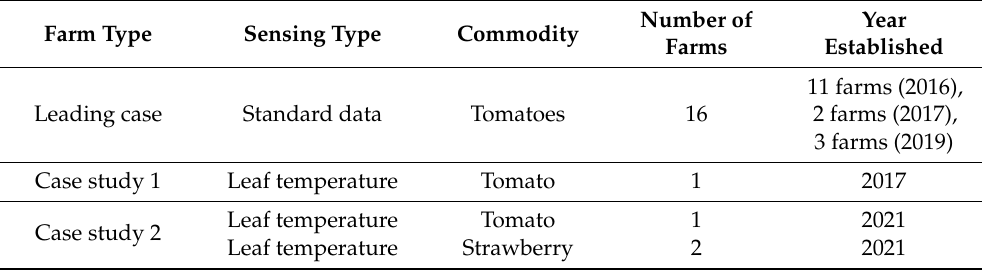
Table 3. An overview of case studies used in this study. For leading cases, data on the following variables were collected: air temperature, humidity, CO 2 , illuminance, wind direction, wind speed, rainfall, and yields. Case study 1 focused on the development of software, hardware, and information collection, while case study 2 was established to improve a framework for data utilization. All farms were equipped with a complex environment controller (mainly for aeration) and nutrient solution suppliers. Number of Year Farm Type Sensing Type Commodity Farms Established 11 farms (2016), Leading case Standard data Tomatoes 16 2 farms (2017), 3 farms (2019) Case study 1 Leaf temperature Tomato 1 2017 Leaf temperature Tomato 1 2021 Case study 2 Leaf temperature Strawberry 2